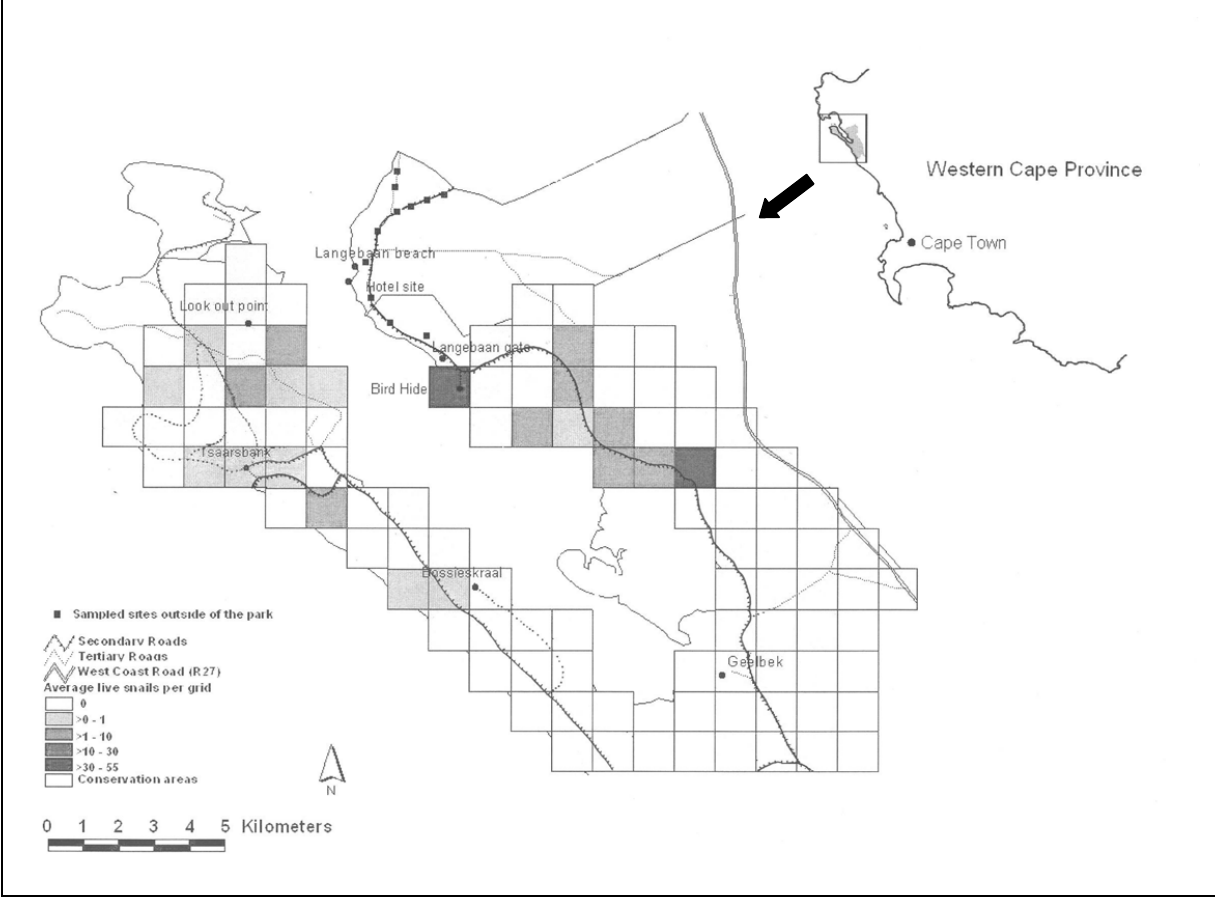
Figure 2 Map of the WCNP showing the density (m -2 ) and distribution of Theba pisana in August 2006 as well as the position of sampled sites outside of the